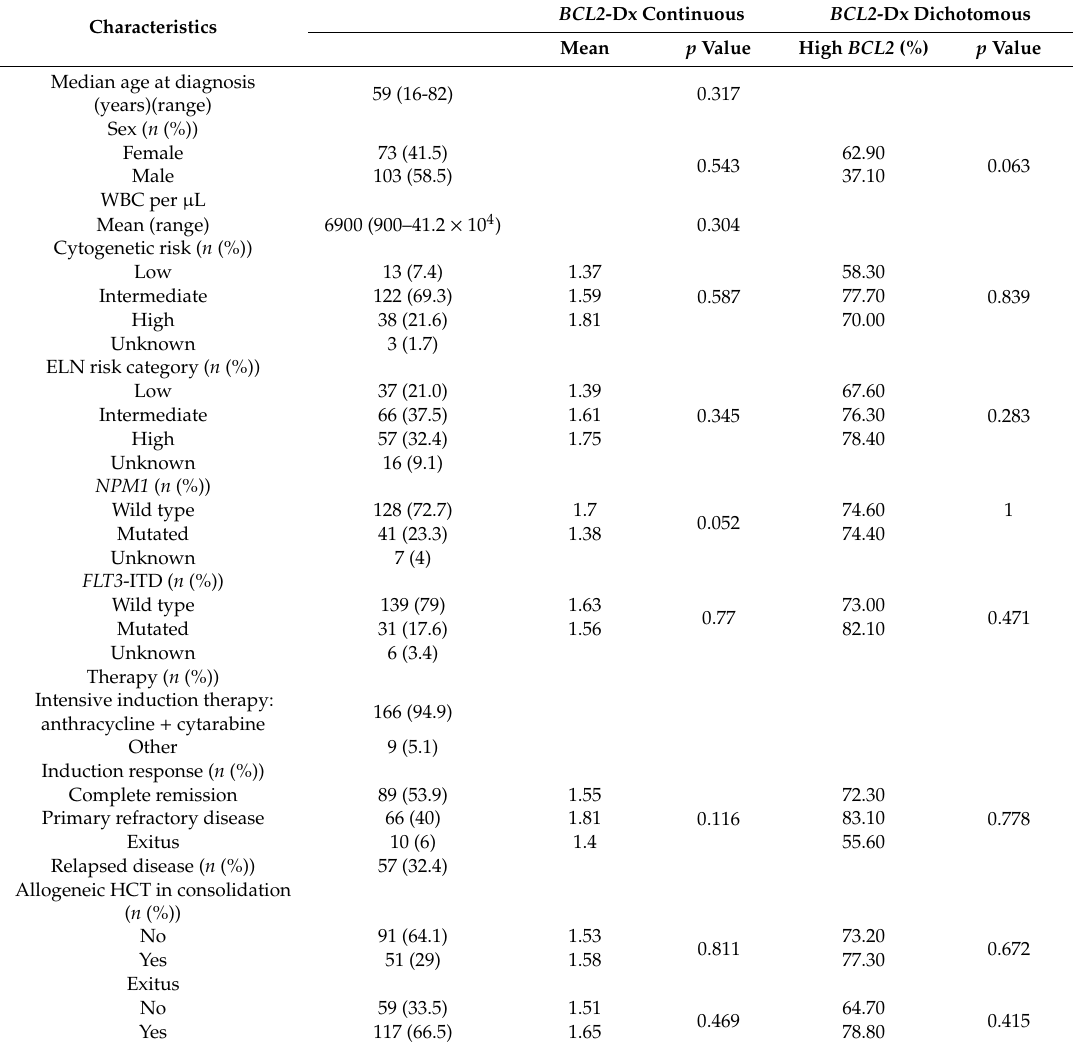
Table 1. Summary of patients’ clinical, biological and therapeutic characteristics and its association with BCL2